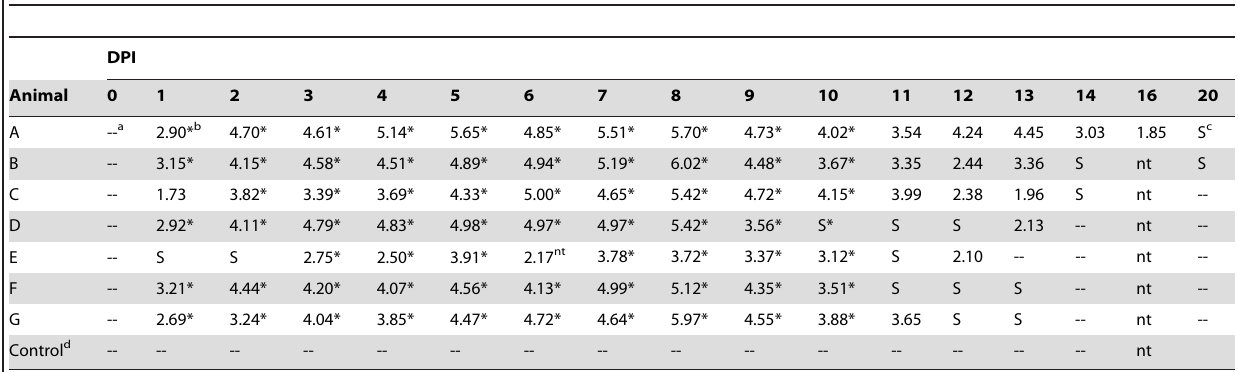
Table 2. Nasal shedding of striped skunks ( Mephitis mephitis ) experimentally infected with an avian influenza virus (H4N6).